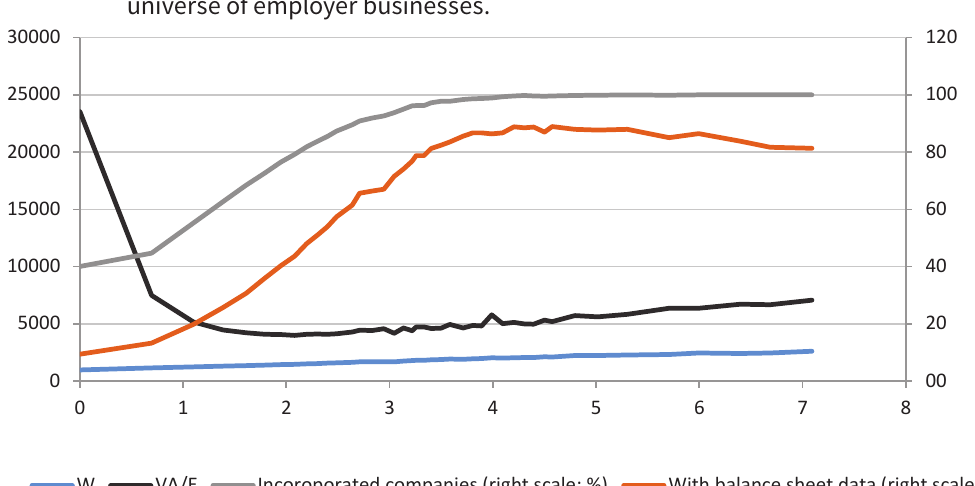
Figure 6 Average labor productivity and average wage by (log) class size, and fractions of incorporated businesses and of firms with balance sheet data within the universe of employer